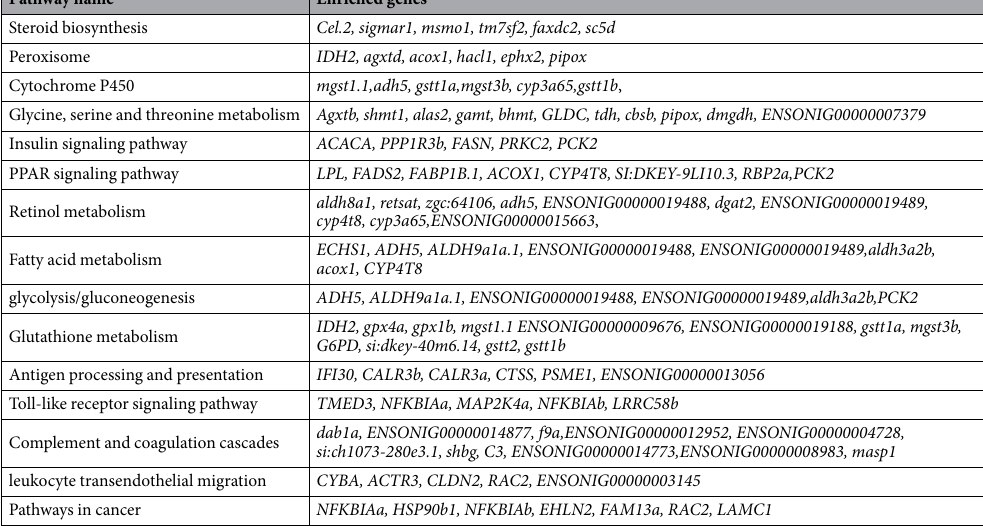
Table 2. Significantly enriched pathways involving differentially expressed genes in heat-stressed GIFT liver.